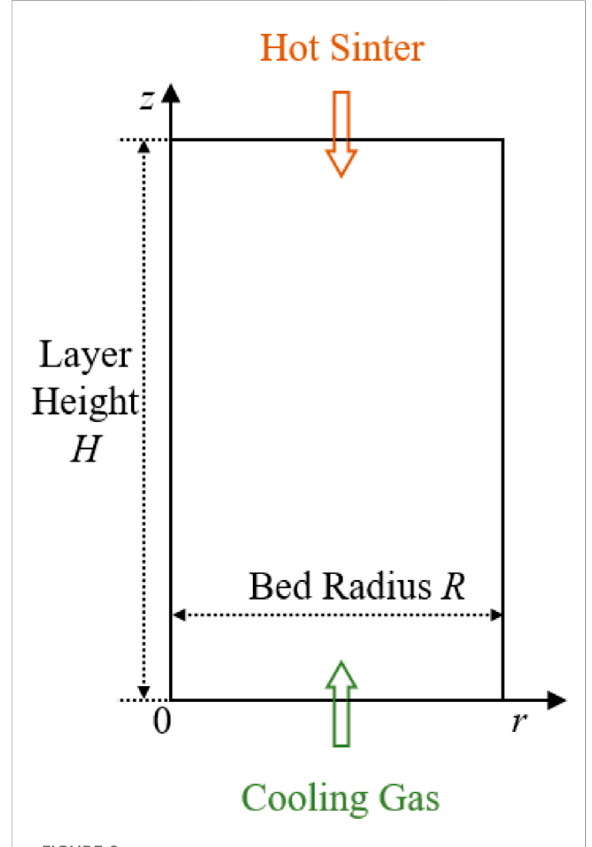
FIGURE 2 Physical model of the cooling section of the sinter vertical cooling